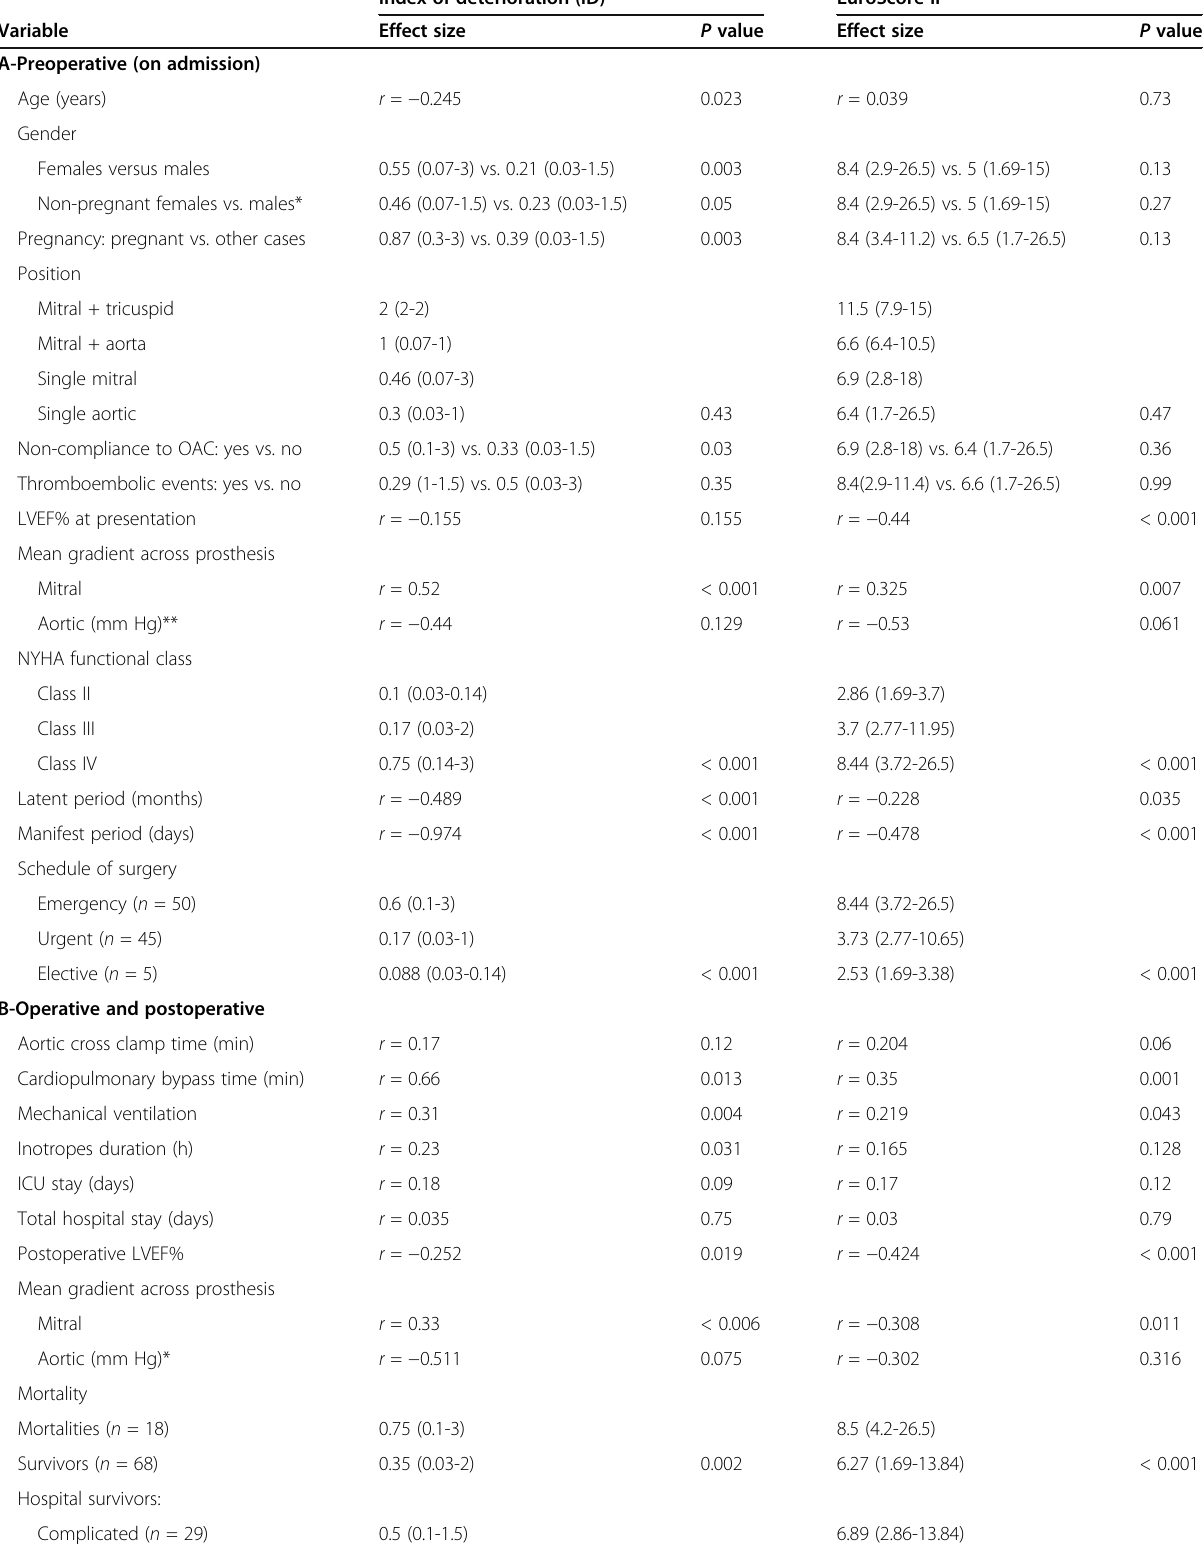
Table 3 Index of deterioration versus EuroScore